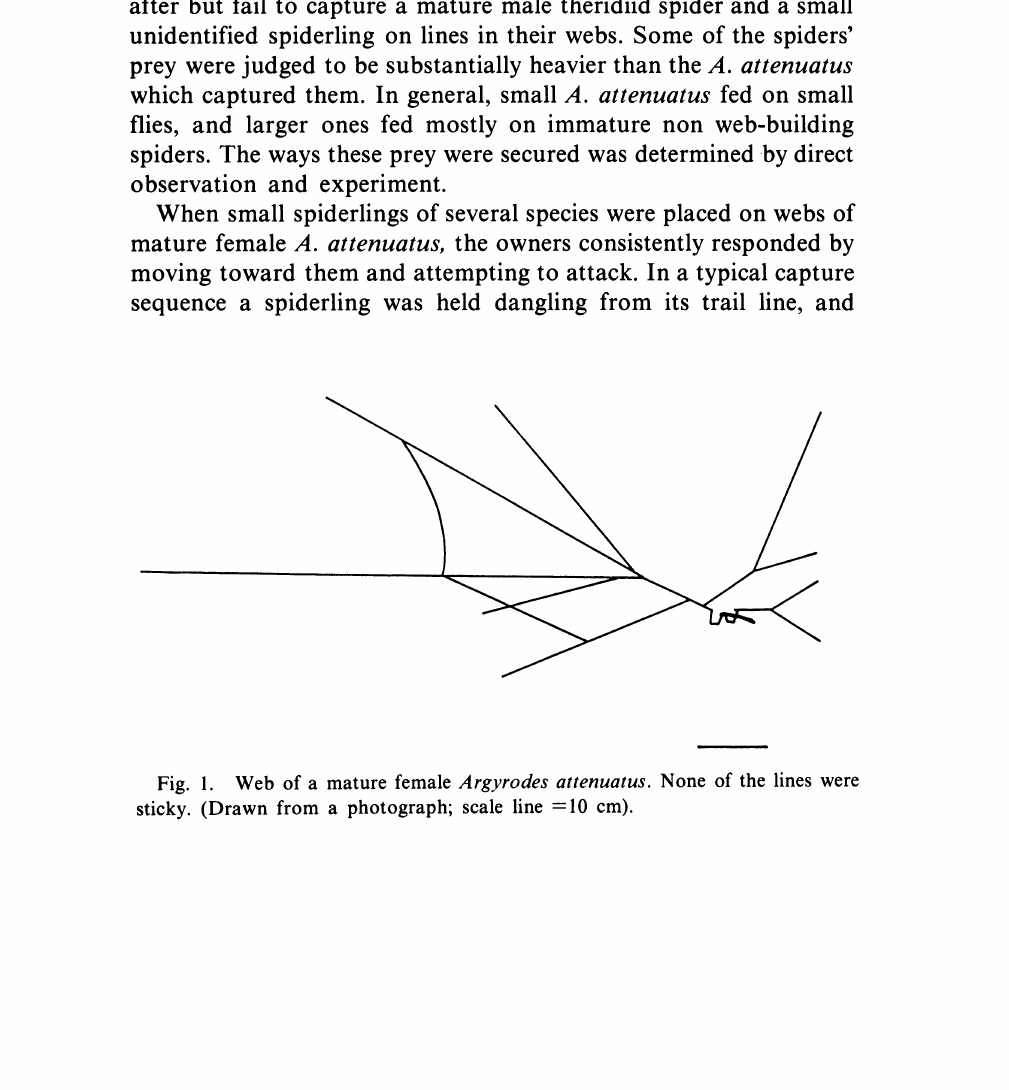
Fig. 1. Web of a mature female Argyrodes attenuatus. None of the lines were sticky. (Drawn from a photograph; scale line --10